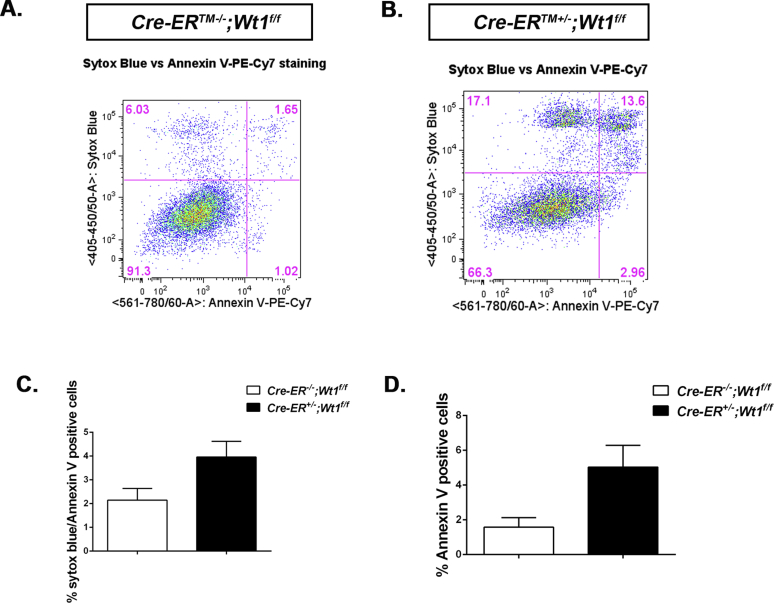
Podocyte apoptosis is increased in CAGG-CreERTM+/−;Wt1f/f transgenic mouse podocytes at day 8 postinduction (A-C). (A,B) Representative flow cytometry results for primary podocytes from day 8 postinduction CAGG-CreERTM −/−;Wt1f/f control and CAGG-CreERTM +/−;Wt1f/f mutant transgenic mice. The abscissa and ordinate represent the fluorescence intensity of Annexin V Cy7 and Sytox blue, respectively. (C) Quantitative analysis of podocyte cell death. Bars represent the mean percentages ± SEM of Annexin V–positive/Sytox blue–positive (late apoptotic/necrotic) podocytes. CAGG-CreERTM −/−;Wt1f/f controls (n = 2) versus CAGG-CreERTM +/−;Wt1f/f mutants (n = 2): 2.1 ± 0.5% versus 4.0 ± 0.7%, P = 0.16 (not significant). Analyzed by Student t-test. (D) Annexin V/Sytox–negative cells (early apoptosis); 1.6 ± 0.56% versus 5.0 ± 1.3%, P = 0.13. Analyzed by Student t-test.